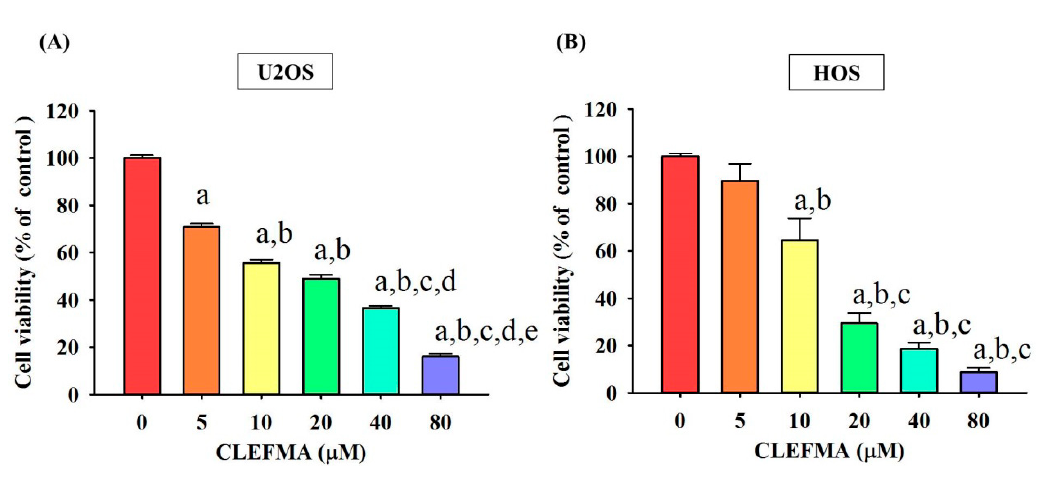
Figure 1. Effects of 4-[3,5-Bis(2-chlorobenzylidene)-4-oxo-piperidine-1-yl]-4-oxo-2-butenoic acid (CLEFMA) on the cell viability of U2OS and HOS cells. Using an [3-(4,5-dimethylthiazol-2-yl)-2,5-diphenyltetrazolium bromide] (MTT) assay, the viability of U2OS and HOS cells treated with CLEFMA (5, 10, 20, 40 and 80 μ M) for 24 h was detected, and the effects are illustrated after quantitative analysis. Results are shown as mean ± S.D. ( A ) n ≥ 4. ANOVA analysis with Scheffe’s posteriori comparison was used. F = 386.619, p < 0.001. ( B ) n ≥ 4. ANOVA analysis with Turkey’s posteriori comparison was used. F = 53.288, p < 0.001. a: Significantly different, p < 0.05, when compared to control. b: Significantly different, p <0.05, when compared to 5 μ M. c: Significantly different, p < 0.05, when compared to 10 μ M. d: Significantly different, p < 0.05, when compared to 20 μ M. e: Significantly different, p < 0.05, when compared to 40 μ M.